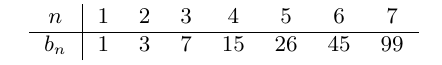
Table 4: Seed values for the recurrence relation